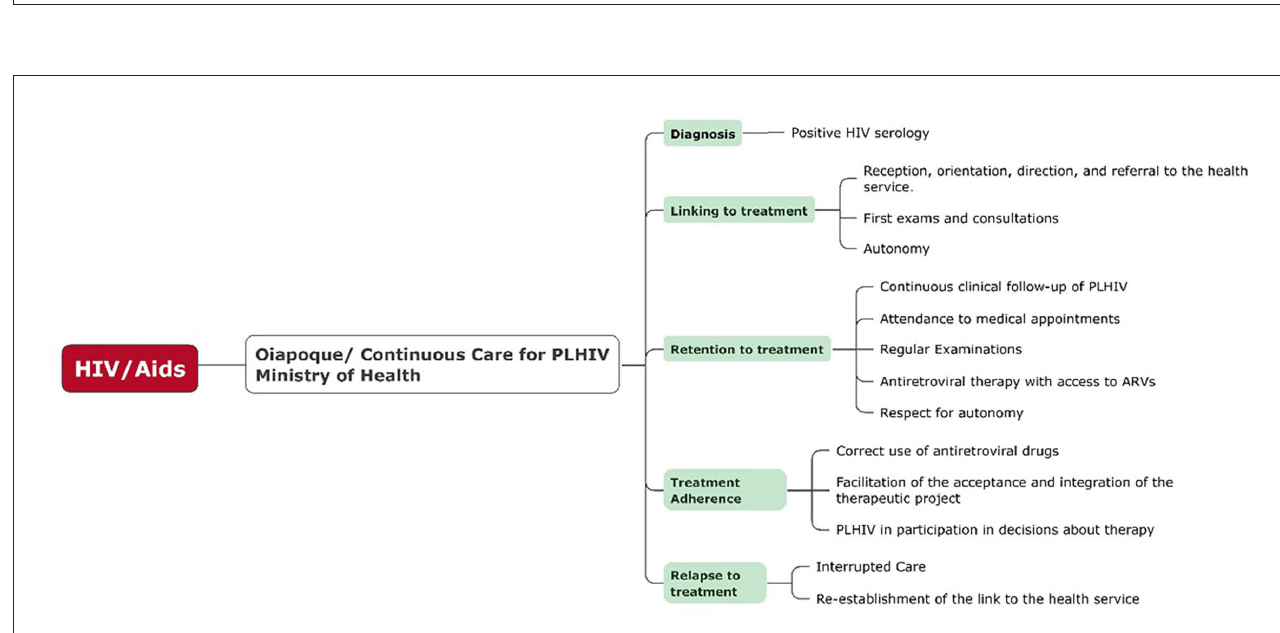
FIGURE2 Required course of continuous care for people living with HIV (PLHIV) as recommended by the Ministry of Health, from diagnosis to continued treatment. Source: Own preparation based on the descriptions of the Manual of Combined Prevention of HIV–Ministério da saúde